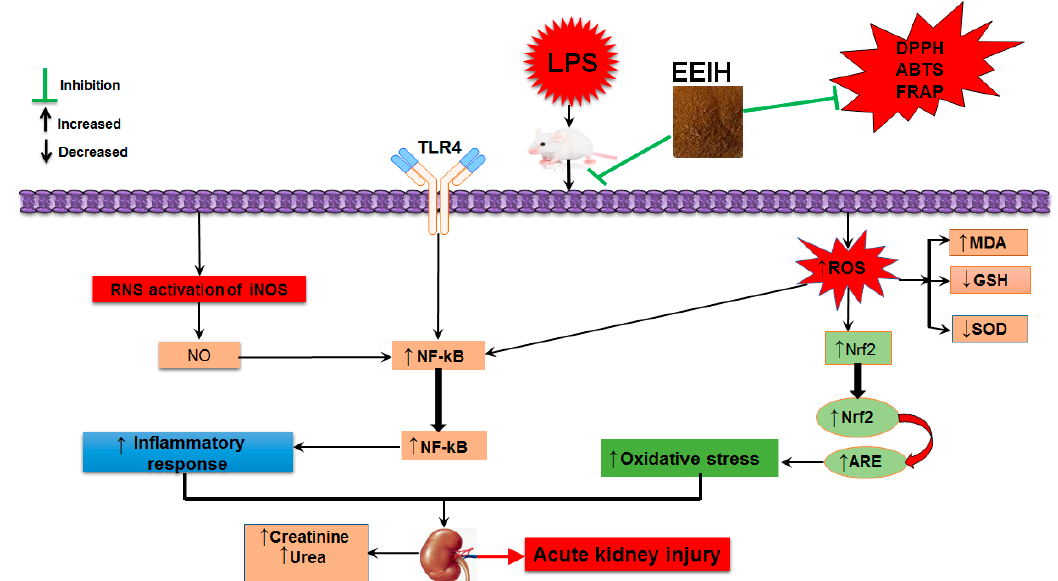
Figure 4. A proposed schematic diagram illustrating the protective effect of EEIH on LPS-induced acute kidney injury. EEIH, ethanol extract of Illicium henryi ; LPS, lipopolysaccharide; DPPH, (2, 2-diphenyl-1-picrylhydrazil); FRAP, ferric-reducing antioxidant power; ABTS, 2,2 ′ -azino-bis-(3-ethylbenzothiozoline-6- sulfonic acid) disodium salt; ROS, reactive oxygen species; RNS, reactive nitrogen species; TLR4, toll-like receptor 4; NF- κ B, nuclear factor- κ B; SOD, superoxide dismutase; MDA, malondialdehyde; GSH, glutathione; NO, nitric oxide; iNOS, inducible nitric oxide synthetase; Nrf2, nuclear factor erythroid 2- related factor 2; ARE, antioxidant response element.